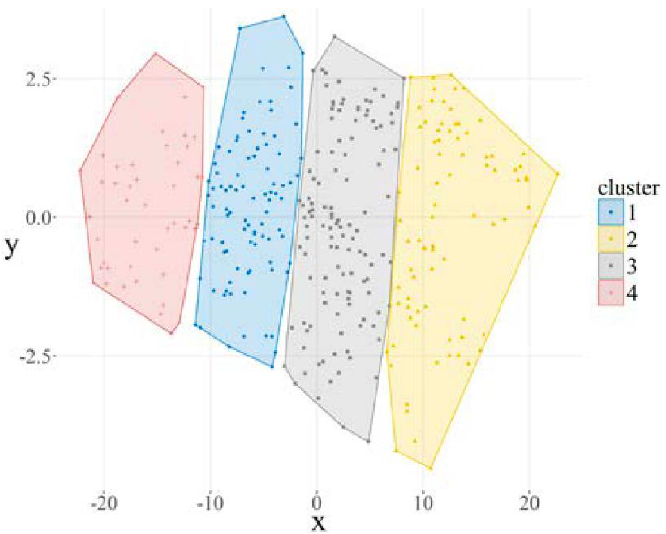
Figure 27. Non-overlapping clusters obtained with the k-means algorithm [22].